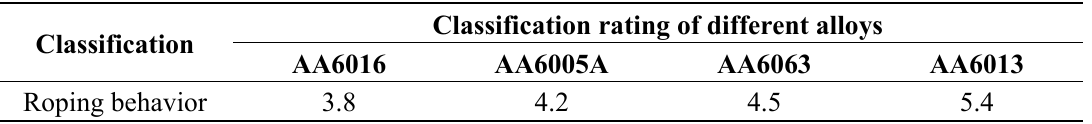
Table 6. Classification of the roping test